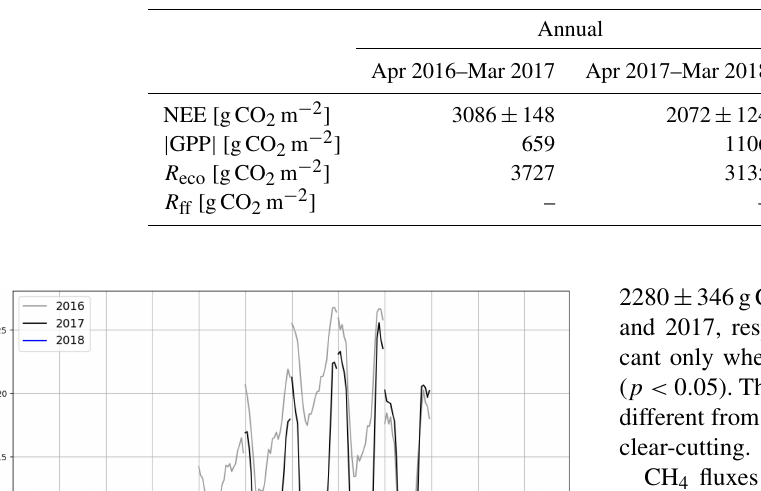
Table 2. Annual and summertime (JJA) balances of net ecosystem exchange (NEE), modelled gross primary production (GPP), and modelled total ecosystem respiration ( R eco ), as well as the modelled summertime sums of forest floor respiration ( R ff ).